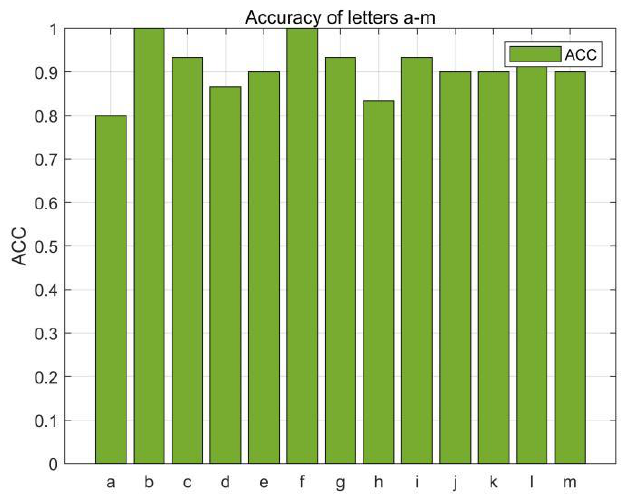
Figure 14. Accuracy of the letters “a–m”.